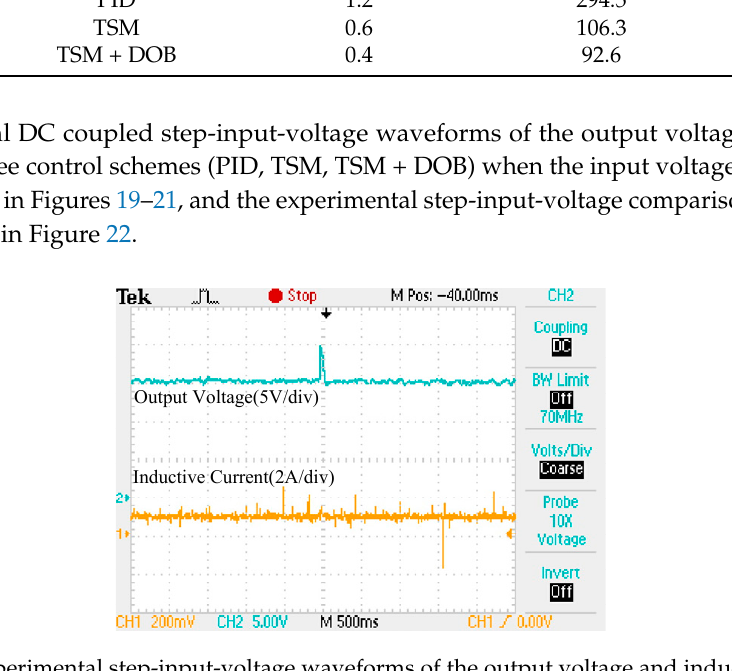
Figure 19. Experimental step-input-voltage waveforms of the output voltage and inductive current under the PID controller. Energies 2018 , 11 , x